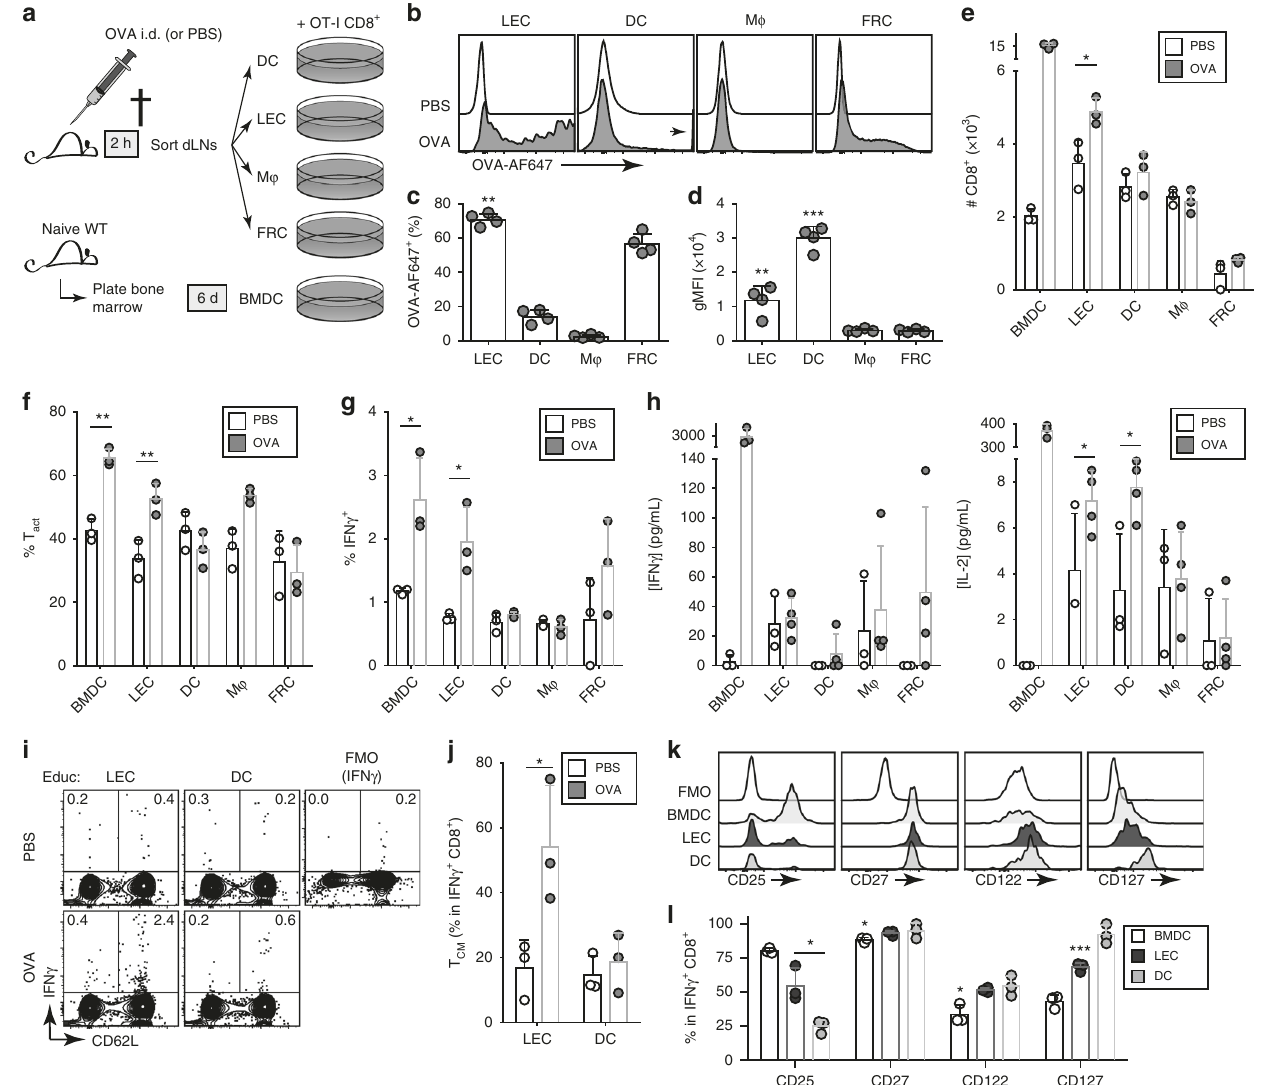
Fig. 2 LECs that had taken up antigen in vivo can activate T cells ex vivo. a Skin-draining LNs from OVA-challenged or control (PBS) mice were sorted for DCs (CD45 + CD11c + ), macrophages (M φ ; CD45 + F4/80 + ), LECs (CD45 – gp38 + CD31 + ), and FRCs (CD45 – gp38 + CD31 – ), which were subsequently co- cultured with naïve OT-I CD8 + T cells for 3 days. As an assay positive control, OT-I cells were co-cultured with OVA/CpG-pulsed BMDCs and analyzed in parallel. b – d Cellular distribution of AF647-labeled OVA (OVA-AF647) at time of sacri fi ce. b Representative histograms, c quanti fi cation of frequency of OVA-AF647 + cells within indicated populations, and d OVA-AF647 MFI gated on OVA-AF647 + cells. e Absolute recovery of live OT-I cells and f , g frequency among all live OT-I cells of f activated phenotype (de fi ned as being positive for CD25, CD44, or CD69) and g intracellular IFN γ + expression. h Endpoint concentrations of IFN γ and IL-2 in the co-culture supernatants. i Representative contour plots depicting IFN γ versus CD62L expression of all live OT-I cells (inset numbers indicate percentage of cells within the gate), with j quanti fi cation of percentage of IFN γ + OT-I cells that exhibit central memory- like (CD44 + CD62L + ; T CM ) phenotype. k , l Gating on IFN γ + OT-I cells, the phenotype of activated, cytokine-producing cells was analyzed for a panel of memory cell-associated markers. k Representative histograms of expression of CD25 (IL-2R α ), CD27, CD122 (IL-2/15R β ), and CD127 (IL-7R α ), quanti fi ed in l as a percentage of marker-positive cells among IFN γ + OT-I cells. * p < 0.05, ** p < 0.01, *** p < 0.001 via Student ’ s t -test. Columns and error bars indicate mean ± SD for n = 3 – 4 from one of two independent